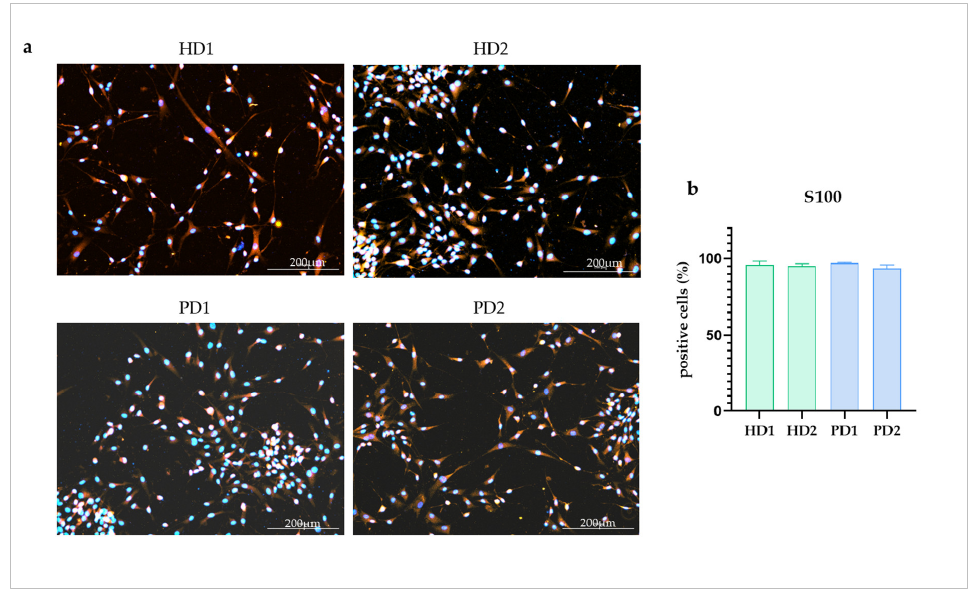
Figure 1. Immunocytochemical analysis of astrocyte marker S100 in the glial cell lines. ( a ), images from glial cultures obtained from healthy donors (HD1, HD2) and from patients with PARK2-associated PD (PD1, PD2). Red—S100, blue—DAPI. ( b ), percentage of S100 positive cells in the studied glial cultures. The data are shown as mean ± SEM.